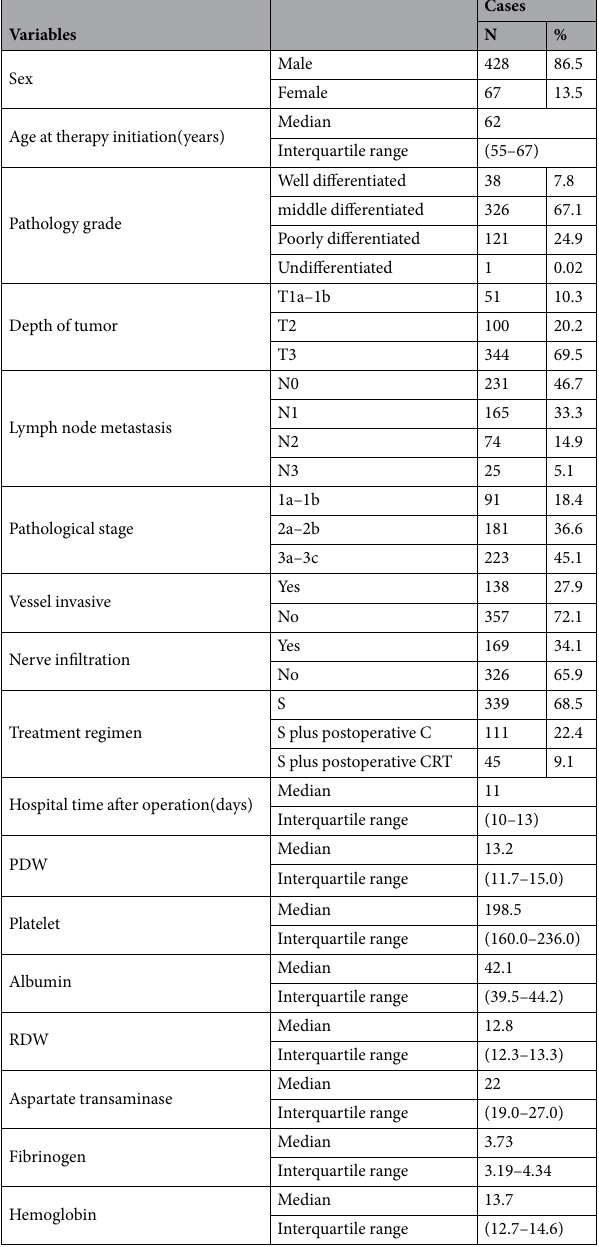
Table 1. Difference in PDW ratio according to clinical characteristics in ESCC patients. Abbreviations: S, surgery; C, chemotherapy; CRT, chemoradiotherapy; PDW, platelet distribution width; RDW, red cell distribution